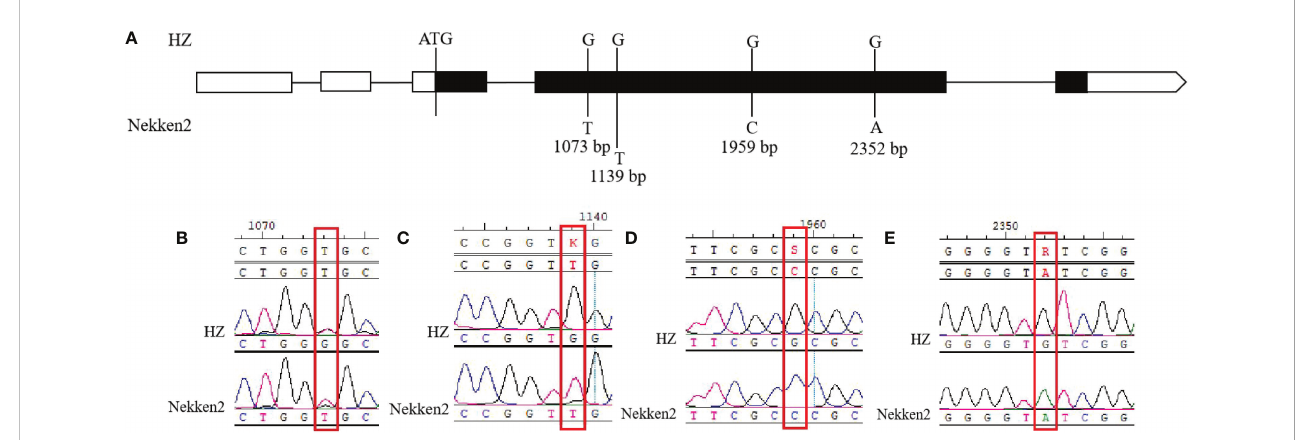
FIGURE 5 Sequence analysis of LOC_Os12g25200 gene. The black region is the exon region, where single base mutations occur. (A) DNA loci difference analysis of LOC_Os12g25200 gene. (B) Site difference at 1073 bp. (C) Site difference at 1139 bp. (D) Site difference at 1959 bp. (E) Site difference at 2352